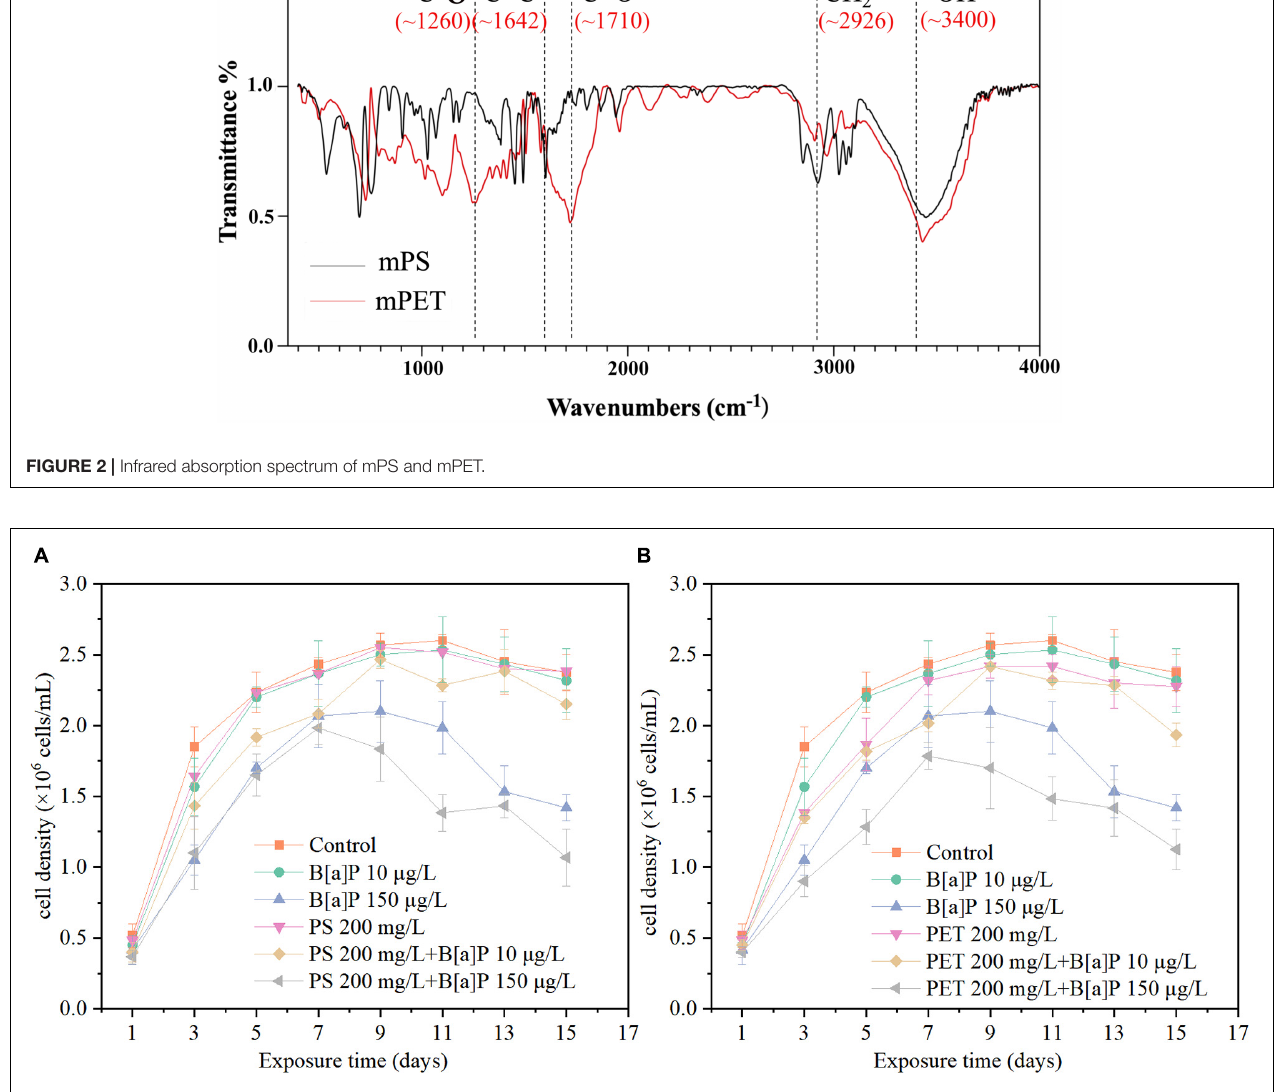
FIGURE 3 | The single and combined effects of microplastics [ (A) mPS and (B) mPET] and B[a]P on the cell density of C.